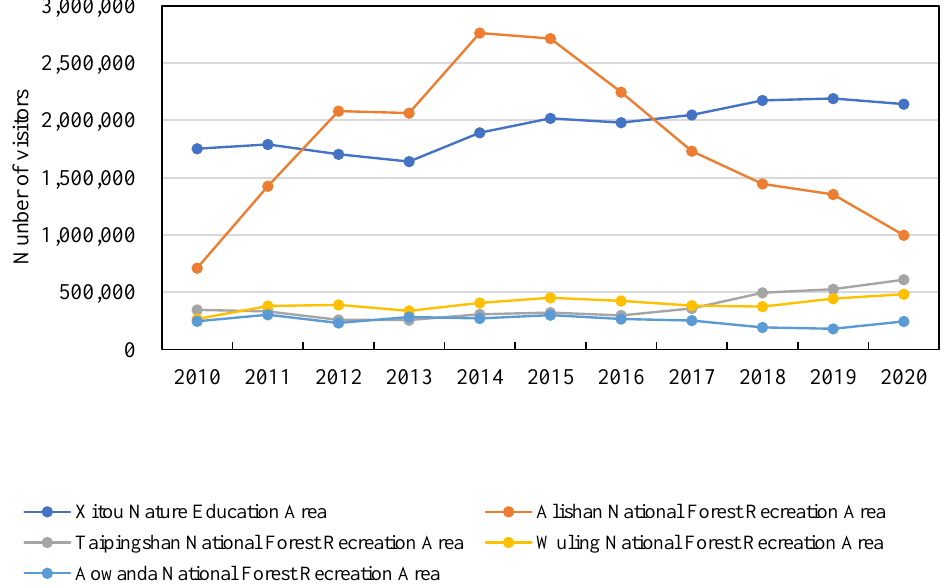
Figure 2. Visitation numbers of top five forest recreation areas in Taiwan (source: Taiwan Tourism Bureau Statistics and Xitou Nature Education Area).